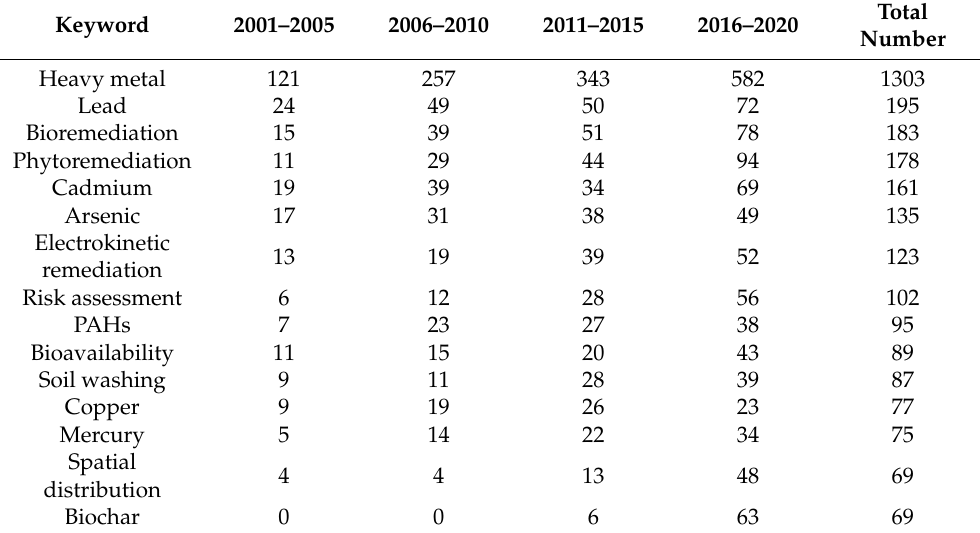
Table 3. Top 15 keyword frequency over